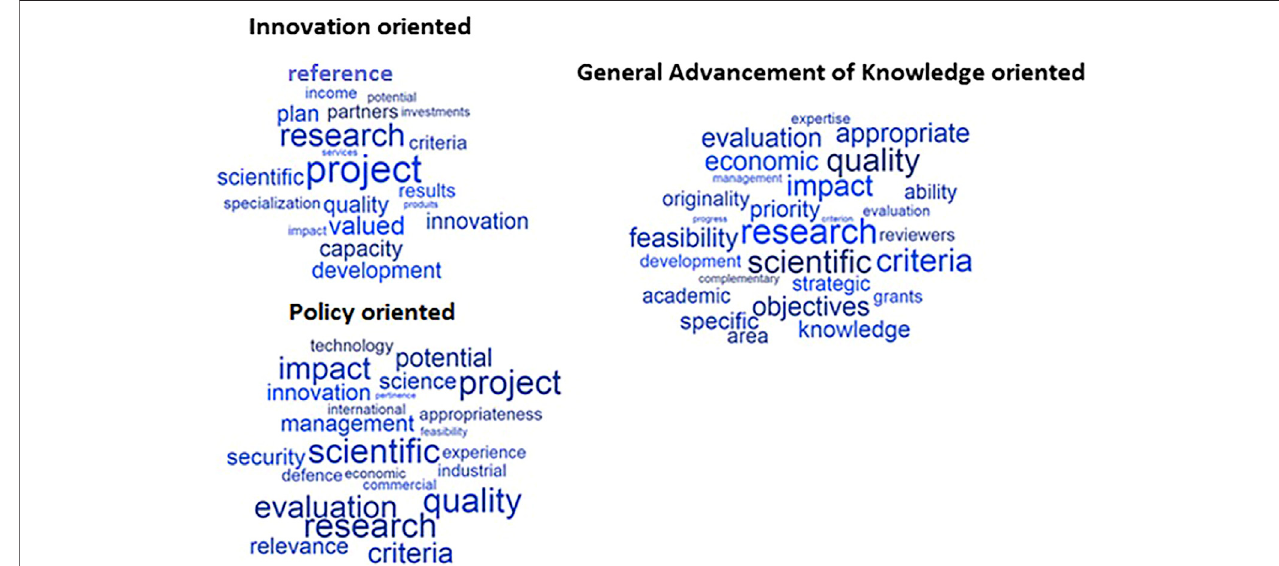
FIGURE 4 | Word Clouds of funding instruments by formal orientation of the instrument.